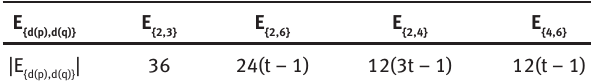
(t) that is based on 1